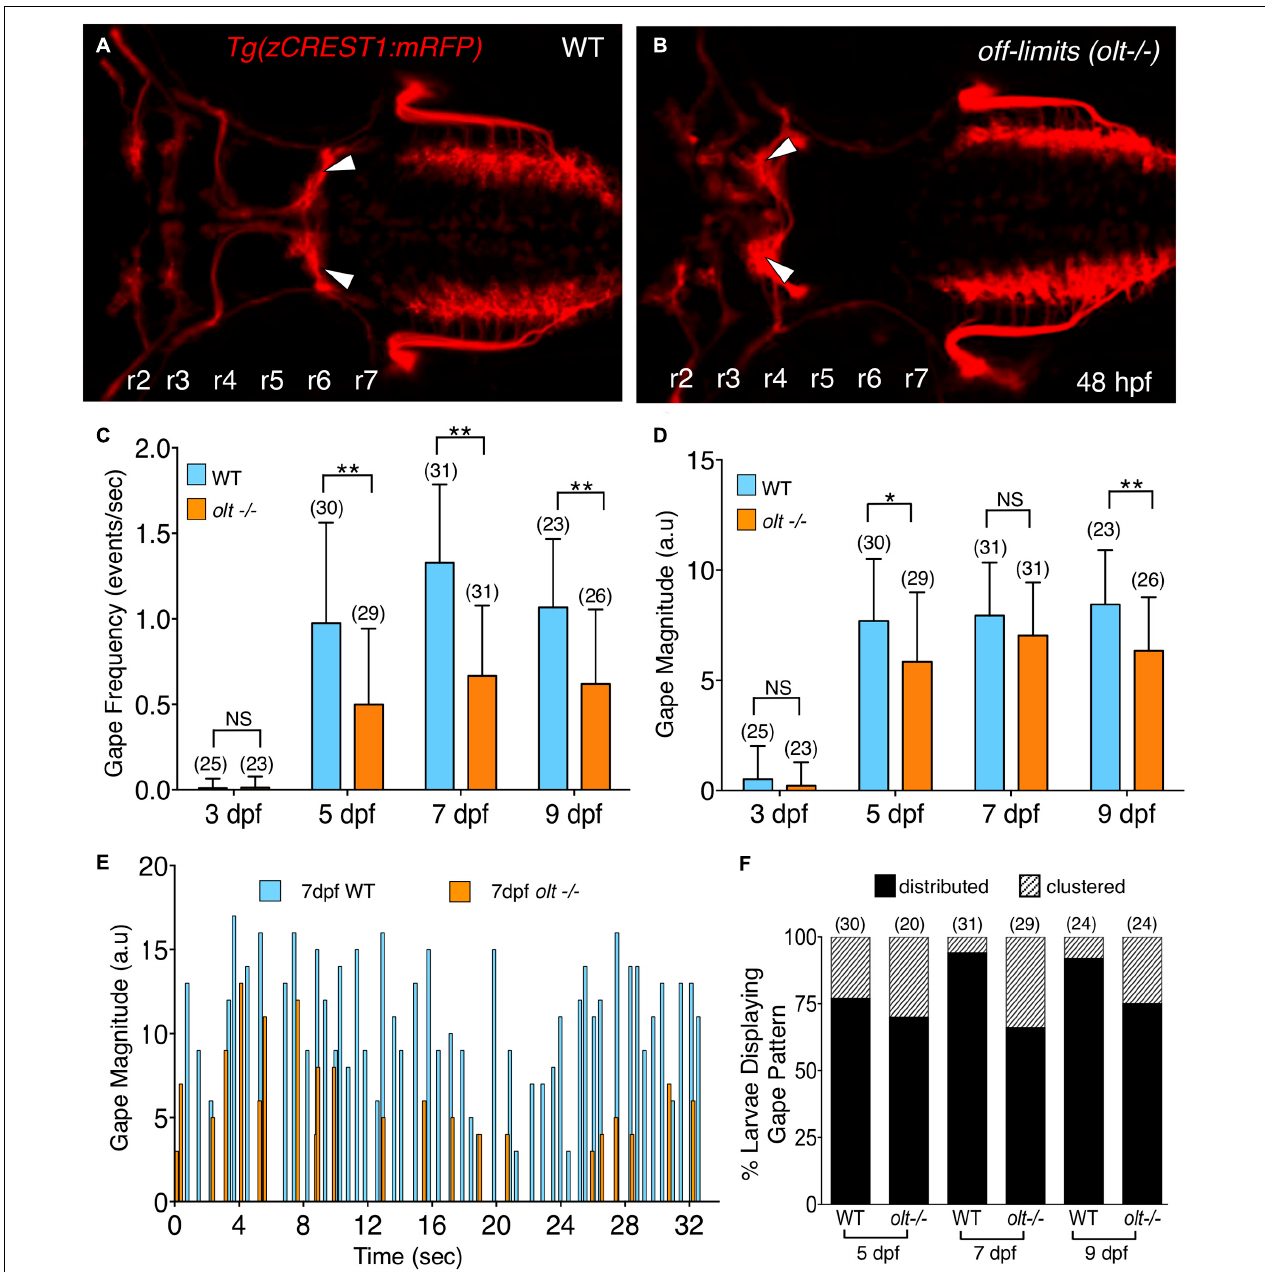
FIGURE 3 | olt mutants have reduced jaw movement. (A,B) Dorsal views with anterior to the left of the hindbrain of 48 hpf Tg(zCREST1:mRFP) in the olt background. (A) Wildtype (WT) sibling with facial branchiomotor (FBM) neurons (arrowheads) migrating into rhombomere 6 (r6). (B) In the olt mutant, FBM neurons (arrowheads) fail to migrate out of r4. (C) Gape frequencies in 5, 7, and 9 dpf olt mutant larvae were significantly reduced compared to wildtype siblings. Notably, the plateauing of gape frequencies after 7 dpf occurred normally in olt mutants. (D) Gape magnitude was significantly reduced in olt mutants compared to wildtype siblings at 5 and 9 dpf, but not at 7 dpf. (E) Gape events in representative 7 dpf olt mutant and wildtype sibling larvae showing reduced gape frequency in the mutant. (F) Gape event patterns were similarly proportioned between wildtype and olt mutant larvae at 5 dpf, with the distributed pattern being the predominant one. In 7 and 9 dpf wildtype larvae, the distributed pattern was almost exclusively seen. Statistical analysis was performed with a two-tailed student t -test (C,D) or Chi-square test (F) . NS, not significant, * p < 0.02, ** p < 0.001. Data pooled from 9 experiments (number of larvae in